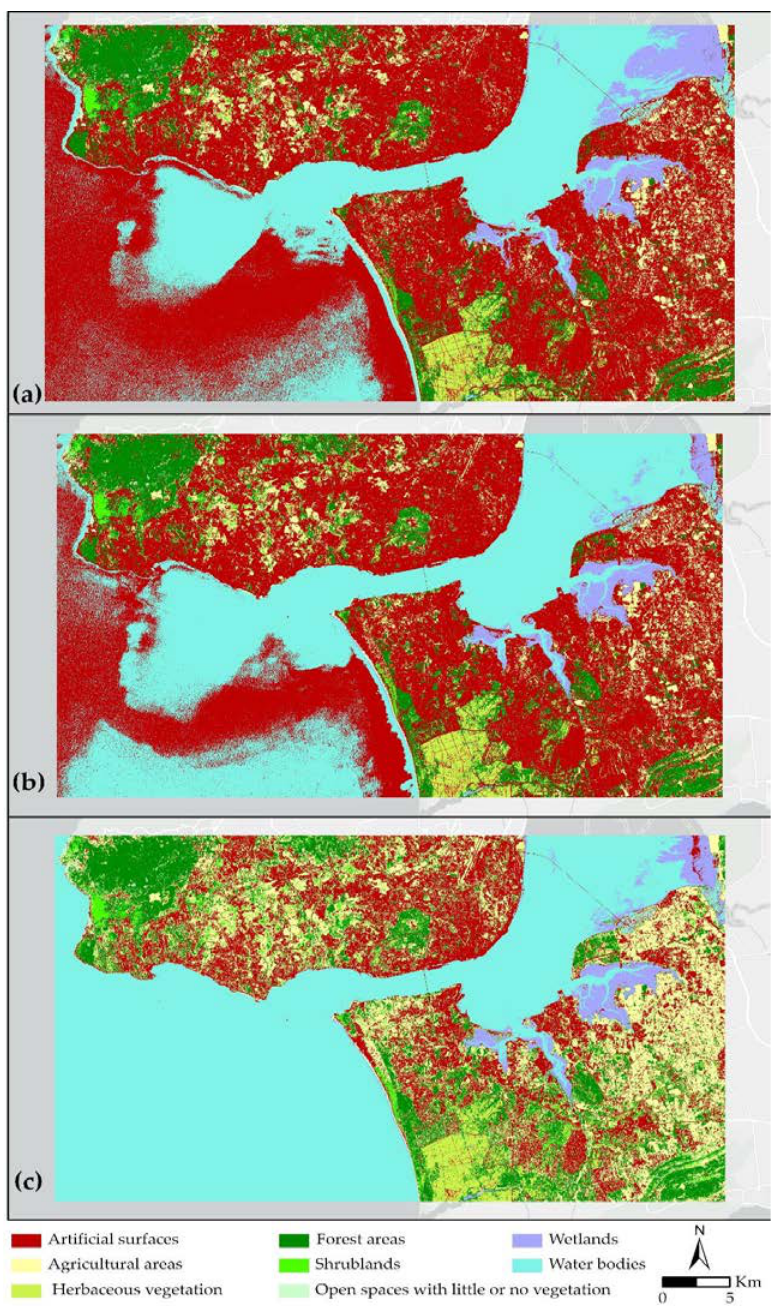
Figure 11. Classification results for study area A obtained with the training samples TS0 ( a ), TS1 ( b ) and TS2 ( c ), extracted, respectively, from TD0, TD1 and TD2.